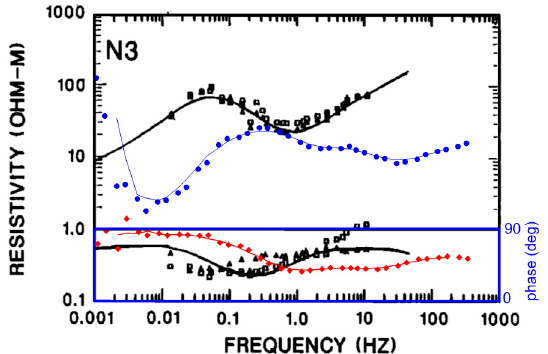
Figure 7. Comparison of example MT sounding curves from QP, Tibet, and the Newberry volcano, Oregon, USA. The foot figure shows the curve from Newberry volcano, the black triangles are resistivity and phase of MT XY direction, and the square are resistivity and phase of MT YX direction [28]. The blue dot and red brick show the resistivity and phase of the MT XY direction of one station in QP.